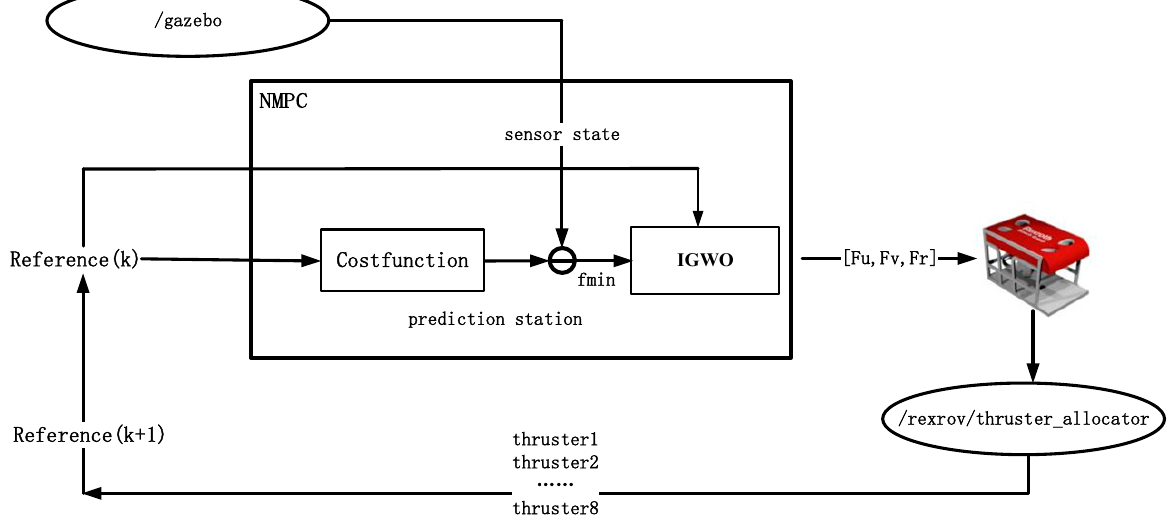
Figure 6. Schematic diagram of controller predictive control principle.